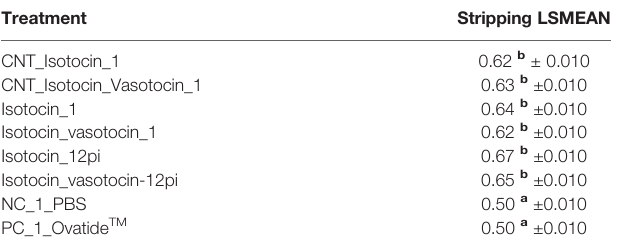
TABLE 4 | Least Squares Means for stripping percentage across the treatments.